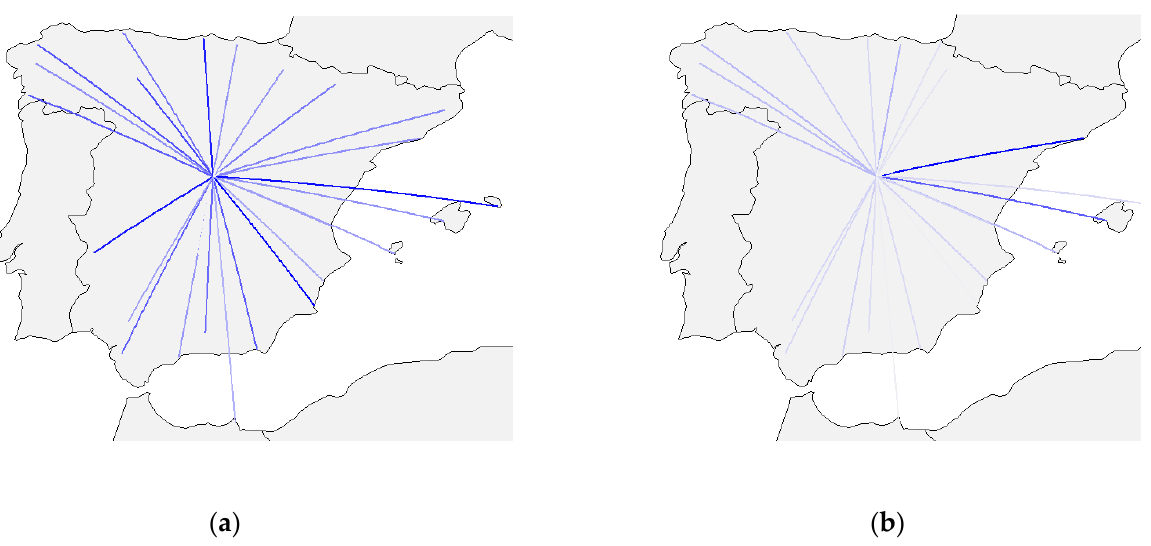
Figure 7. Carbon dioxide emissions from main domestic corridors operating in MAD airport, where a rough sketch means more emissions than the thinner one as follows: ( a ) Partial emission per passenger and per route (arithmetic average: 72.58, standard deviation: 13.76); ( b ) Total emission of routes concerned. Source: own elaboration from the data provided by [19,20].